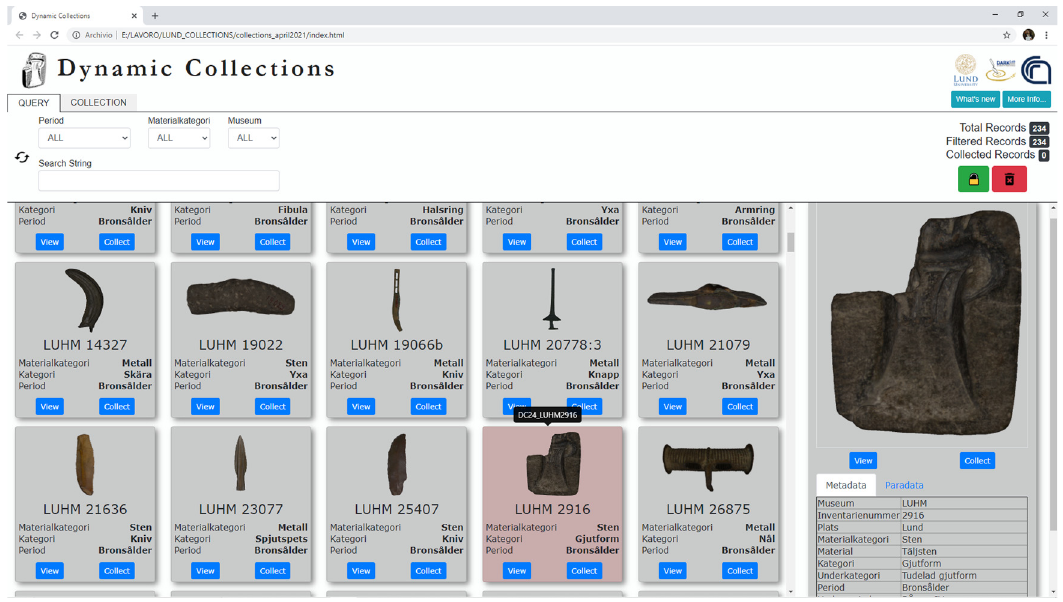
Figure 7: The database - like interface. Users may browse the whole repository, using fi lter and search tools, access each object ’ s meta - and paradata, launch the 3D viewer, and collect objects for their custom